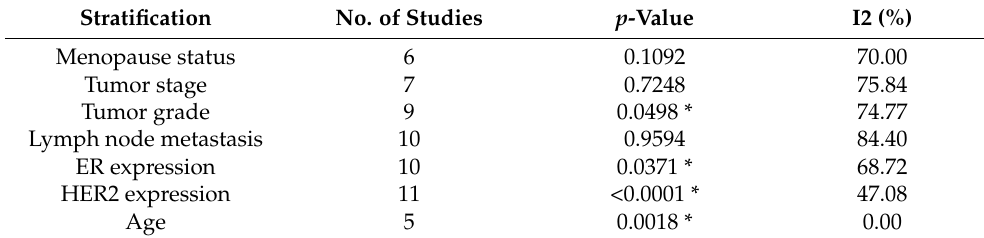
Table 6. Meta regression summary table.